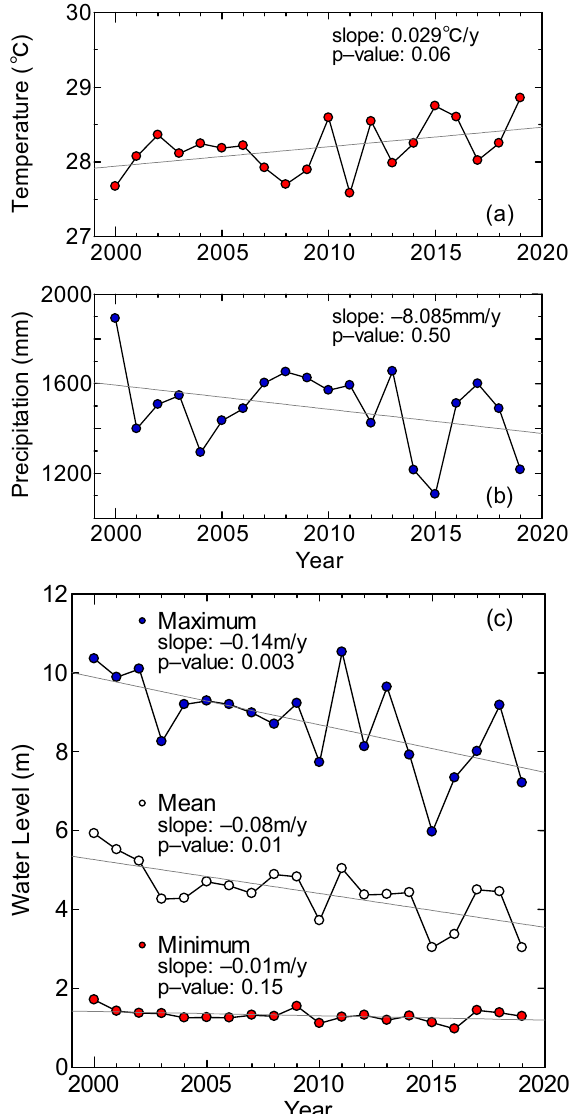
Figure 4. Trends of ( a ) annual air temperature, ( b ) precipitation, and ( c ) water level. Figure 5 shows the long-term variations in the annual maximum, mean, and mini- mum daytime water temperatures. The annual maximum daytime water temperature in- creased by approximately 0.17 °C per decade, with a p-value of 0.38. The annual mean daytime water temperature decreased by approximately 0.18 °C per decade, with a p- value of 0.22. The annual minimum daytime water temperature exhibited a statistically significant downward trend, decreasing by approximately 0.91 °C per decade, with a p- value of 0.002, contrary to the temperature increases associated with recent climate change. The difference between the maximum and minimum annual water temperatures has increased since 2010, indicating that water temperature fluctuations have become more pronounced. The smallest annual difference was 6.9 °C (2002) and the largest was 11.0 °C (2016).